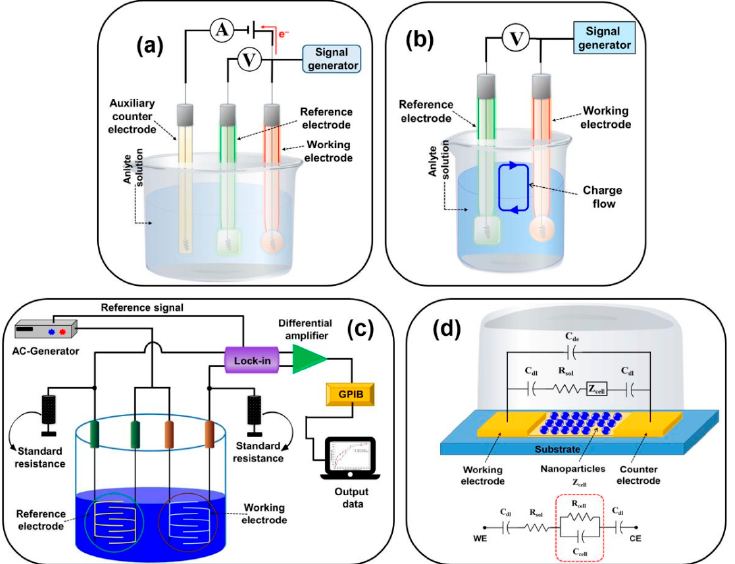
Figure 3. Schematic diagram of ( a ) amperometric/voltammetric, ( b ) potentiometric, ( c ) conducto- metric biosensors, and ( d ) impedimetric biosensor with the relative equivalent circuit [16] (Cdl = double-layer capacitance of the electrodes, Rsol = resistance of the solution, Cde = capacitance of the electrode, Zcell = impedance introduced by the bound nanoparticles, and Rcell and Ccell are the resistance and capacitance in parallel).